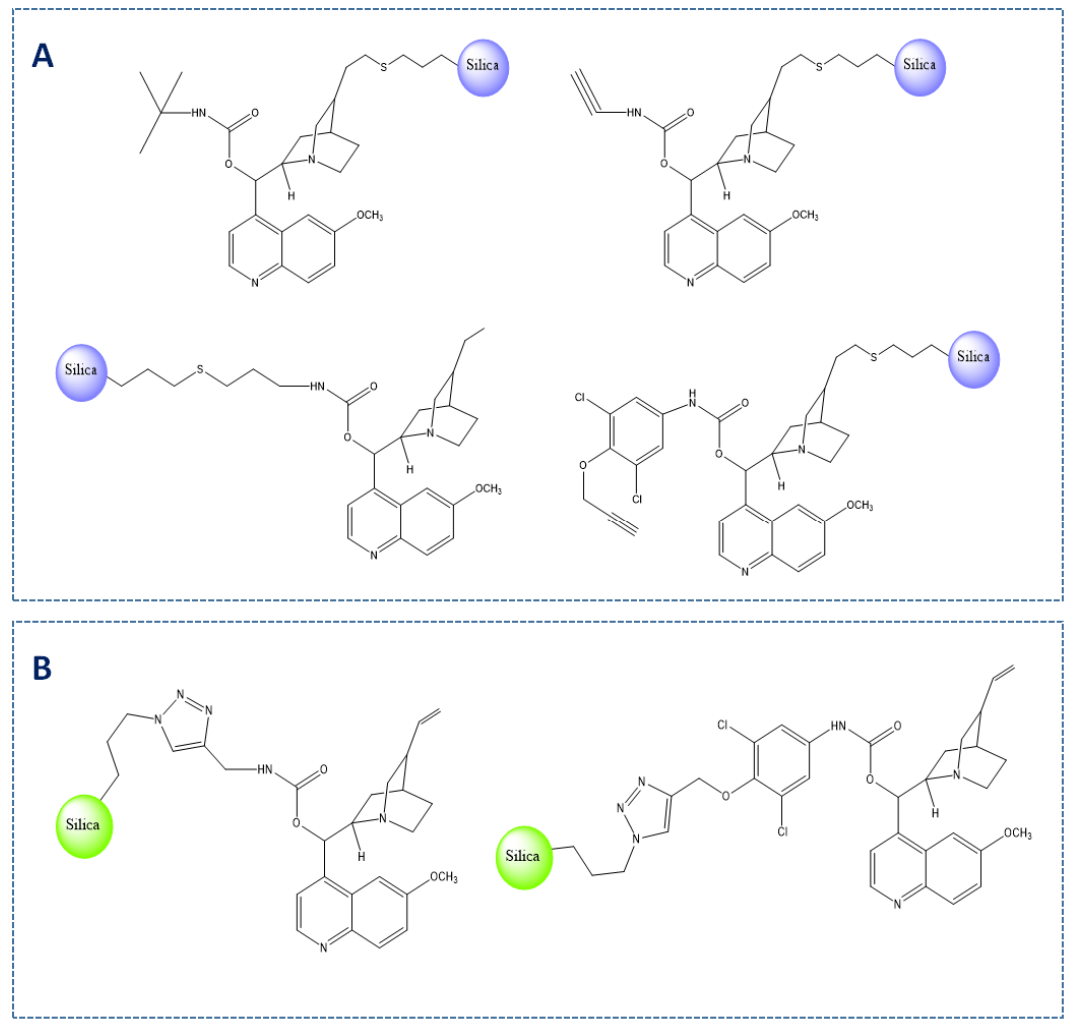
Figure 6. Anion-exchange-based chiral stationary phases synthetized through thiol-ene ( A ) and alkyne–azide ( B ) reactions.